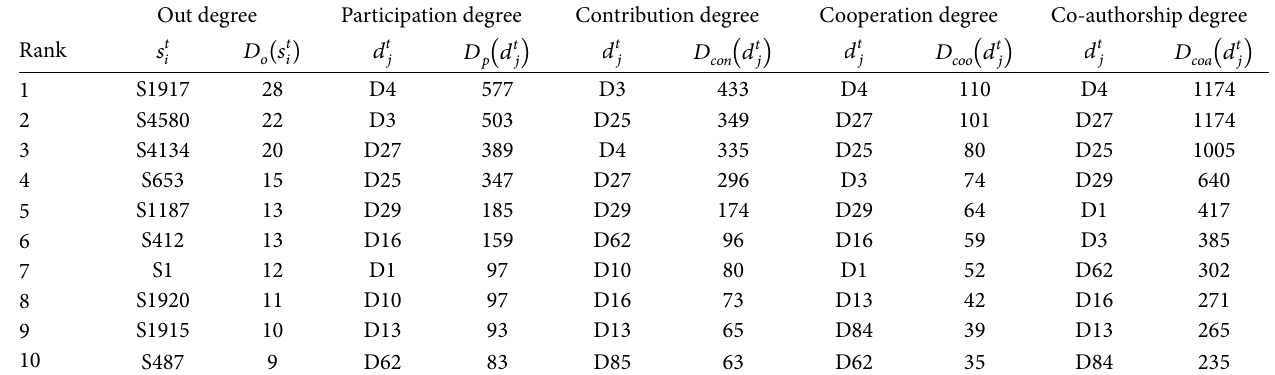
Table 3: The top ten standards and drafters in high indicators till 2007.